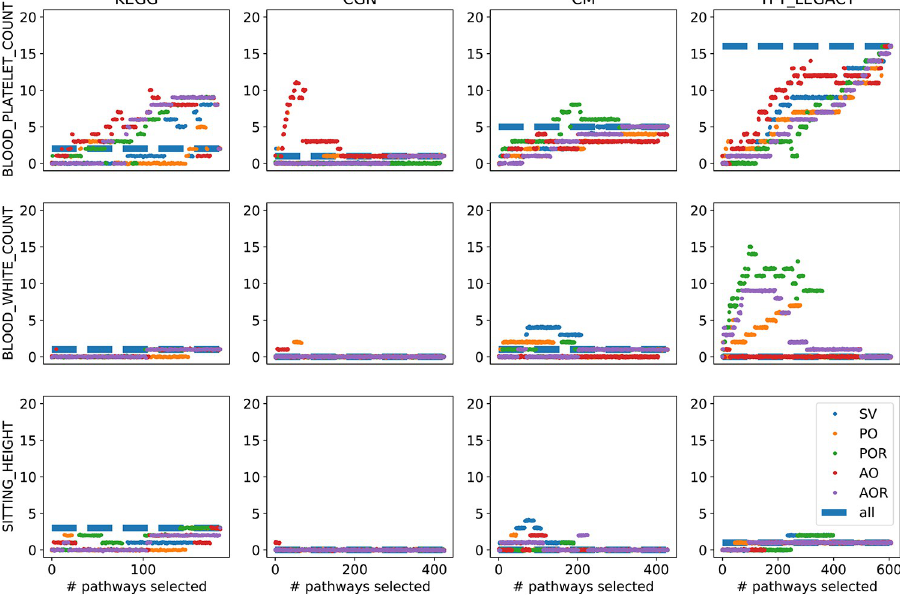
Fig 4. Significant pathways detected. We show results on three selected association traits for the four collections of gene sets. In each plot, the x -axis represents the number of pathways included in the multiple statistical testing while the y -axis represents the number of statistical significant pathways found. The different colours represent the different proposed orderings as in the legend. We used FDR correction for multiple testing and α = 0.05.